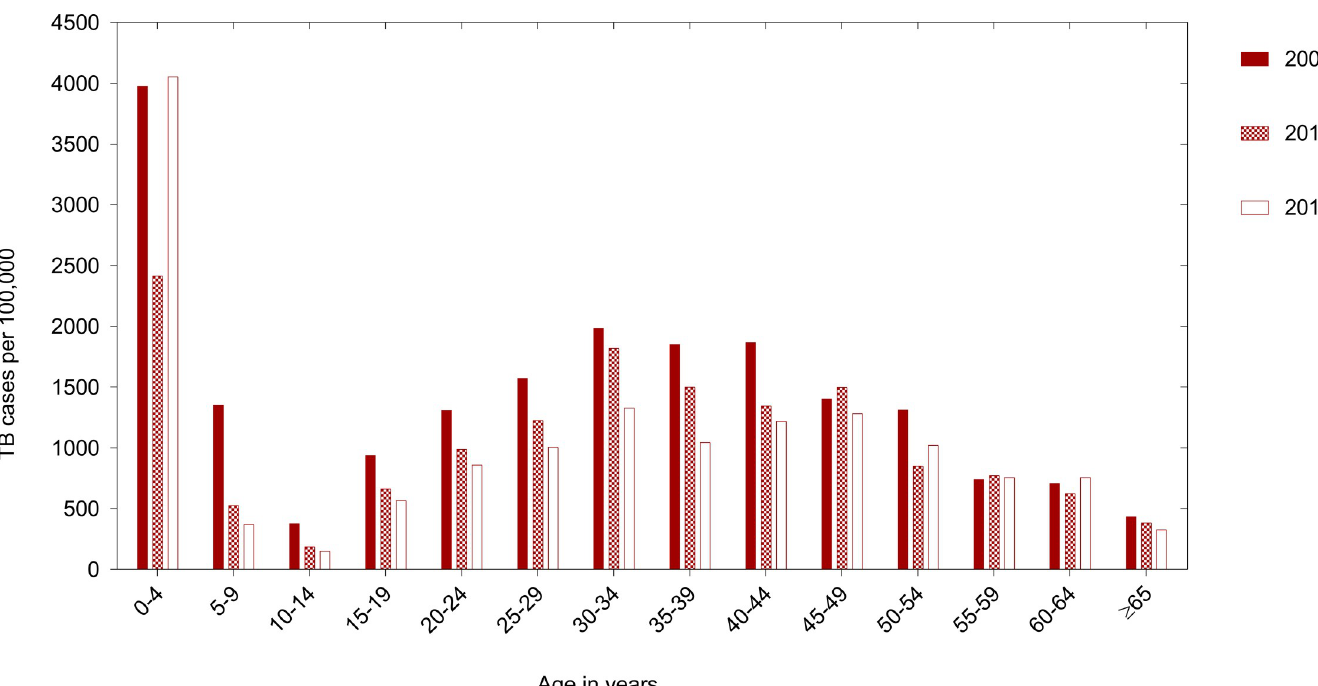
Fig 1. General population TB rates by age in 2005, 2010 and 2015. Legend: TB = Tuberculosis disease (all patients). TB rates reduced from 379 to 188 to 151 patients per 100,000 among adolescents aged 10–14 years old; and from 938 to 663 to 566 patients per 100,000 among adolescents aged 15–19 years old, in 2005, 2010 and 2015